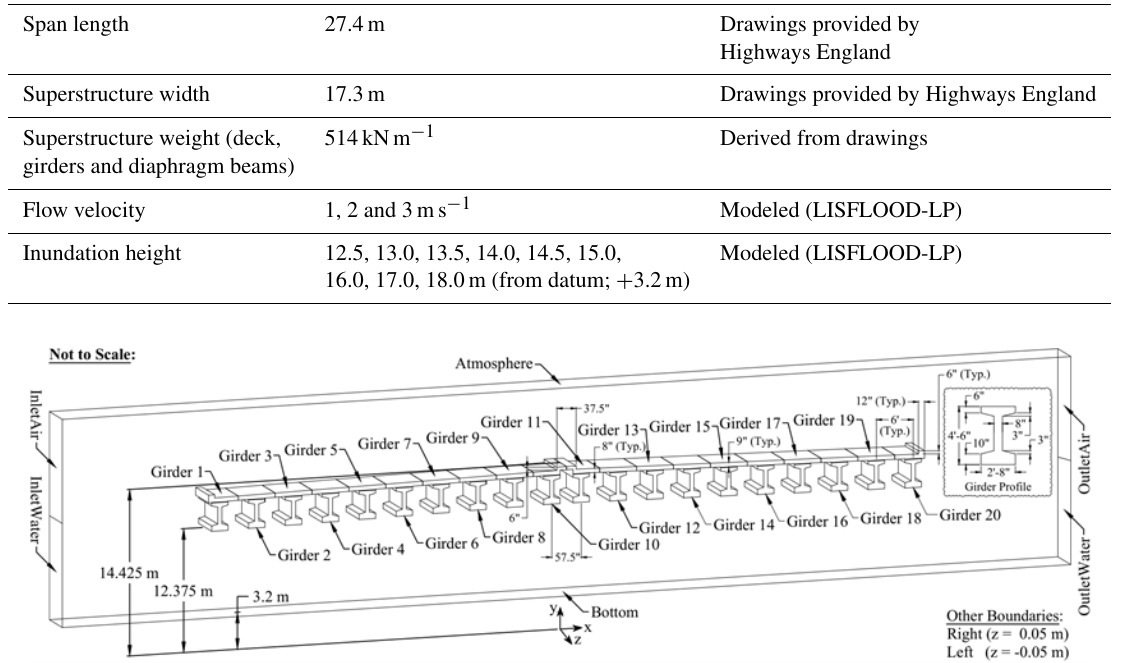
Figure 5. OpenFOAM model geometry and boundary